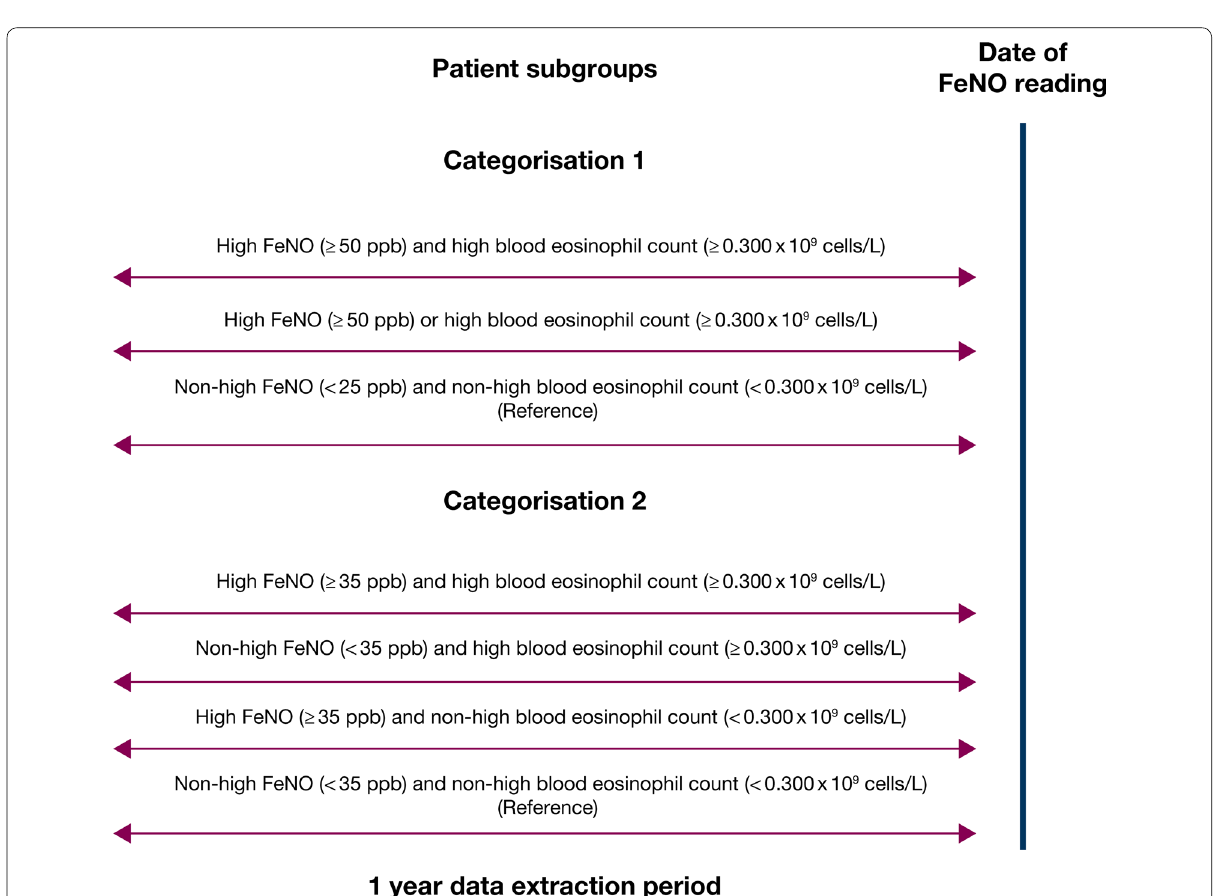
Fig. 1 Study design. The study period consisted of the year prior to the latest documented FeNO reading. FeNO fractional exhaled nitric